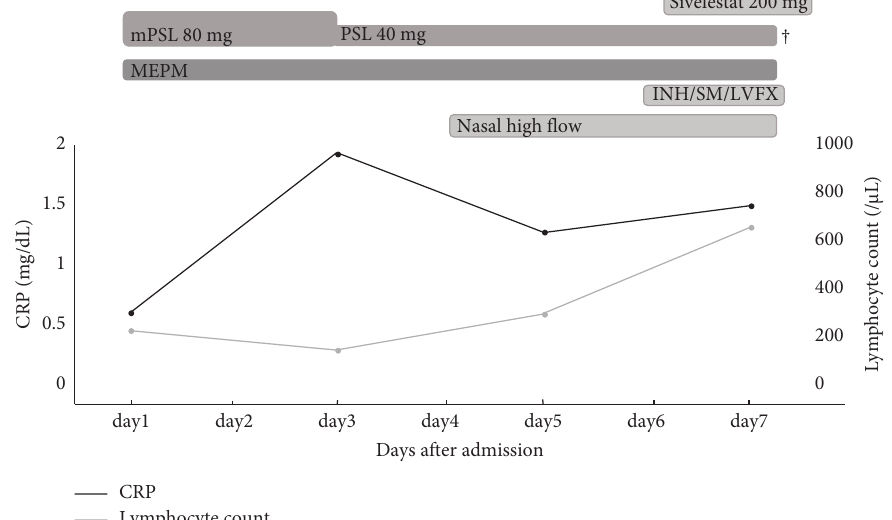
Figure 3: The clinical course. CRP, C-reactive protein; INH, isoniazid; LVFX, levofloxacin; MEPM; meropenem; mPSL, methylpred- nisolone; PSL, prednisolone; SM, streptomycin; TB,